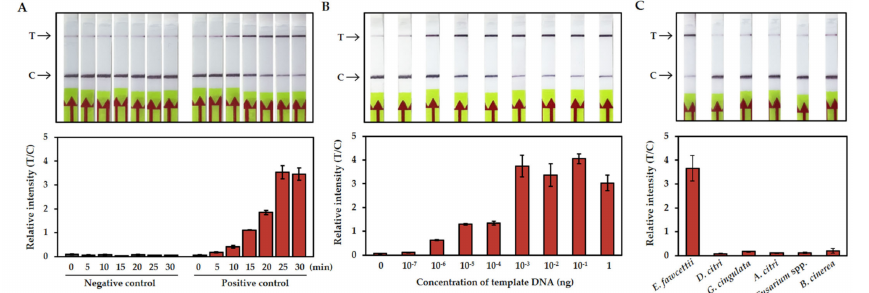
Figure 3. The limit of detection with RPA-CRISPR/Cas12a-LFA. ( A ) Optimal incubation time of the CRISPR/Cas12a reaction. The LFA strip results for different reaction times are shown at the top, and the relative quantifications of band intensities are shown below. NC: negative control, no template, PC: positive control with 1 ng of the total gDNA of E. fawcettii , T: test line, C: control line. ( B ) The sensitivity of the RPA-CRISPR/Cas12a-LFA detection was determined using ten-fold serially diluted gDNA as a template. ( C ) The specificity of the RPA-CRISPR/Cas12a-LFA detection was tested with the causal agents of five common fungal citrus diseases. All the experiments were performed three times, and representative pictures are shown. The error bars indicate the standard